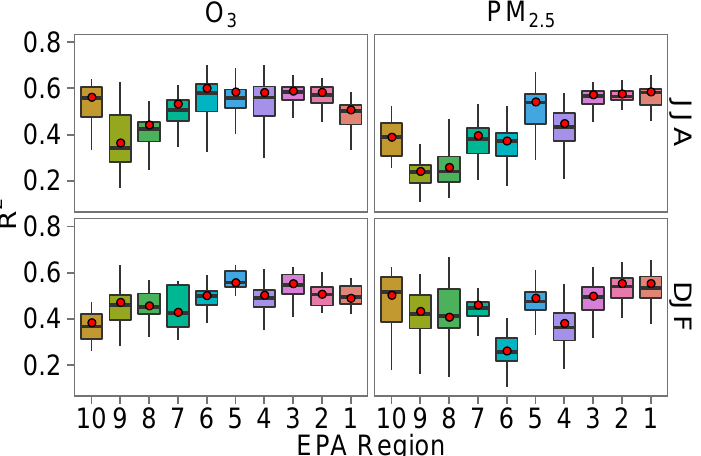
Figure 11. Ordinary least-squares coefficient of determination ( R 2 ) between observed pollutant concentrations and the reduced set of mete- orological variables selected in this analysis. Results are shown by pollutant (O 3 or PM 2 . 5 ), EPA region (see Figs. 4, 5, 7, and 8), and season (JJA is summer, DJF is winter). Red circles indicate median values using the full set of variables, for comparison. Refer to Table 2 for the listing of the reduced and full set of variables. Box plot whiskers mark 5th and 95th percentile R 2